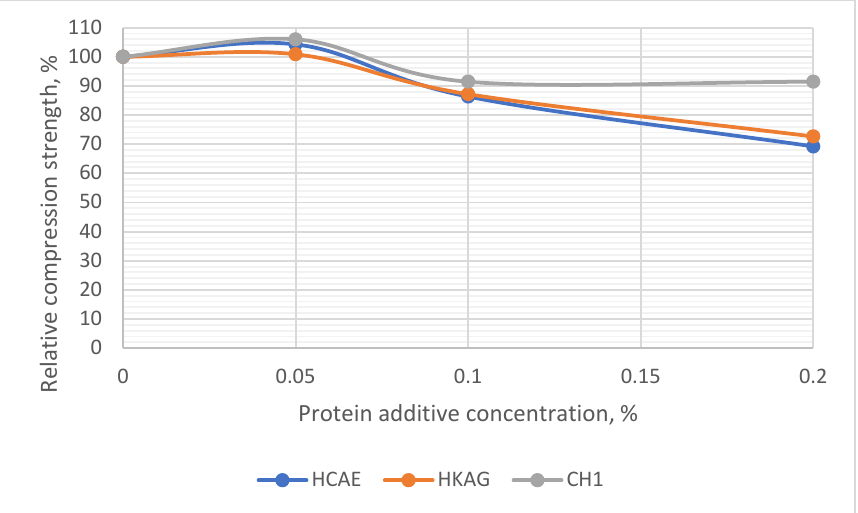
Figure 12. The relative compression strength of plasters with different concentrations of protein additives.